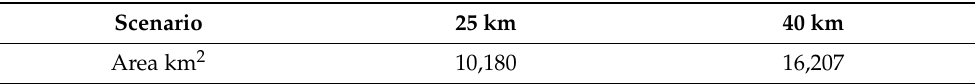
Table 1. UAE’s results for solar energy applicable areas for 25 km and 40 km scenarios.